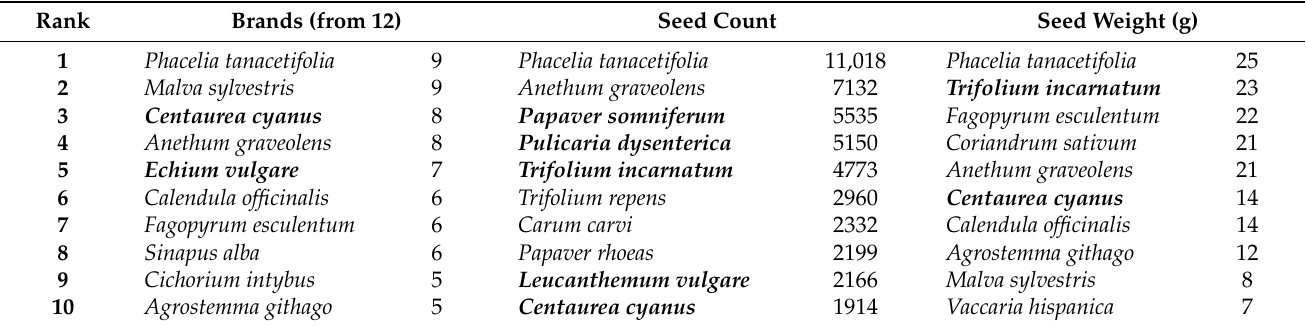
Table 5. The most common plant species occurring in wildflower seed mixes available in Ireland based on the number of brands in which the species occurred, the total number of seeds per packet, and the total seed weight (g) per packet. Names in bold represent native Irish plant species.